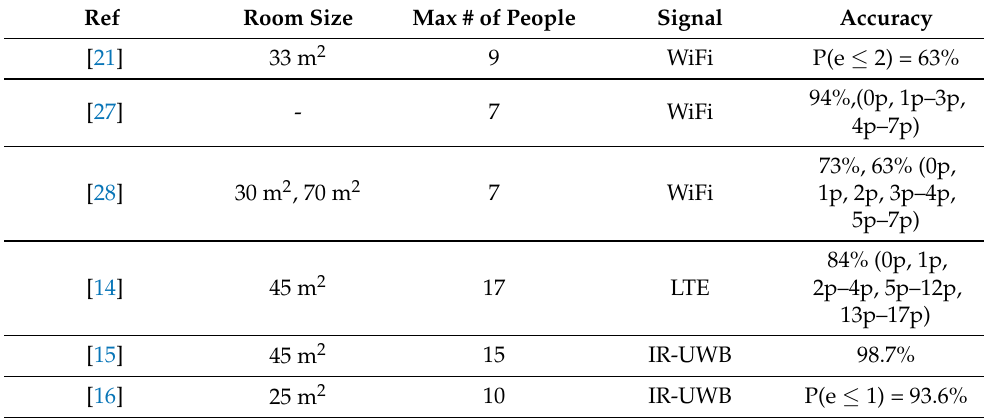
Table 5. Comparison of device-free crowd counting